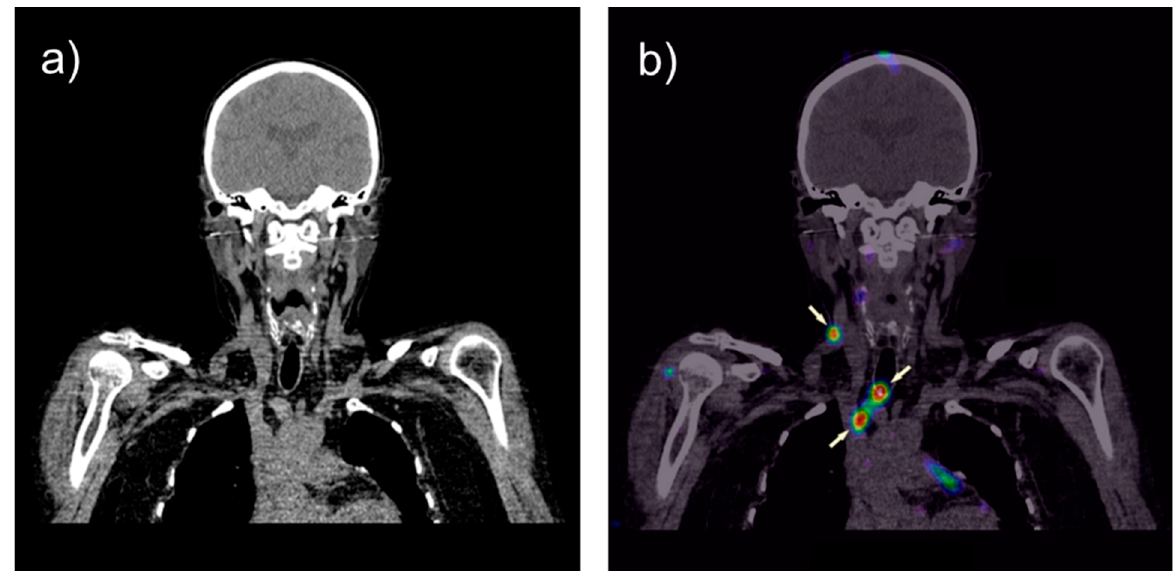
Figure 2. CT ( a ) and fused [ 111 In]In-CP04 SPECT/CT ( b ) images in coronar orientation. Neck lymph node metastases and tumor infiltration around the tracheotomy tube (arrows) in a female patient with MTC are visible; images performed 24 h after injection of 210 MBq (50 µg peptide). Scan was performed within GRAN-T-MTC (ERA-NET on Translational Cancer Research (TRANSCAN), First Joint Transnational Call (JTC 2011) on: “Validation of biomarkers for personalised cancer